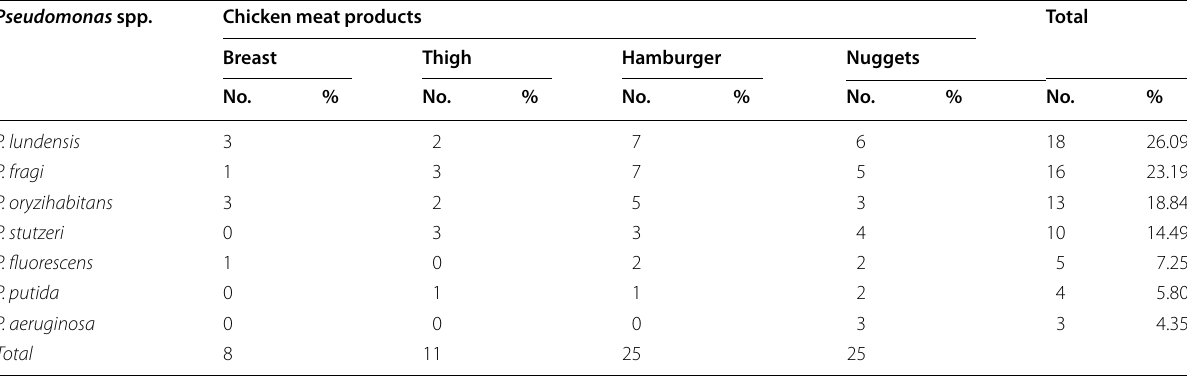
Table 3 Pseudomonas spp. recovered from chicken meat products Pseudomonas